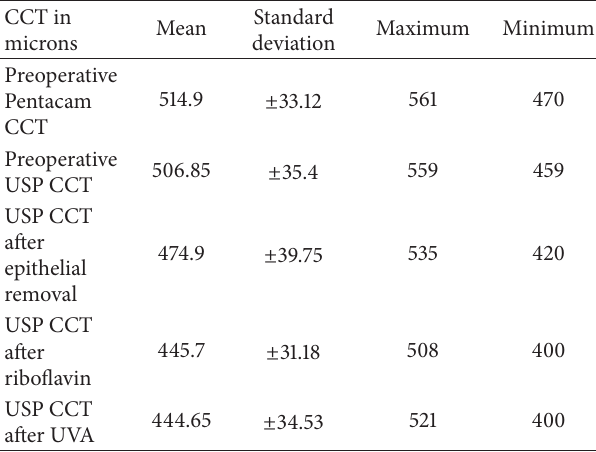
Table 1: Summary of central epithelial thickness